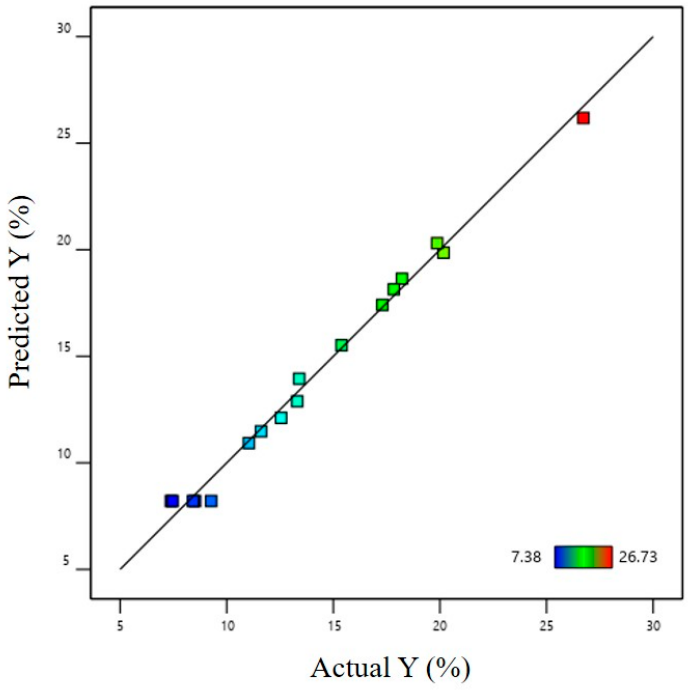
Figure 6. Distribution of actual and predicted values of maximum thinning rate.